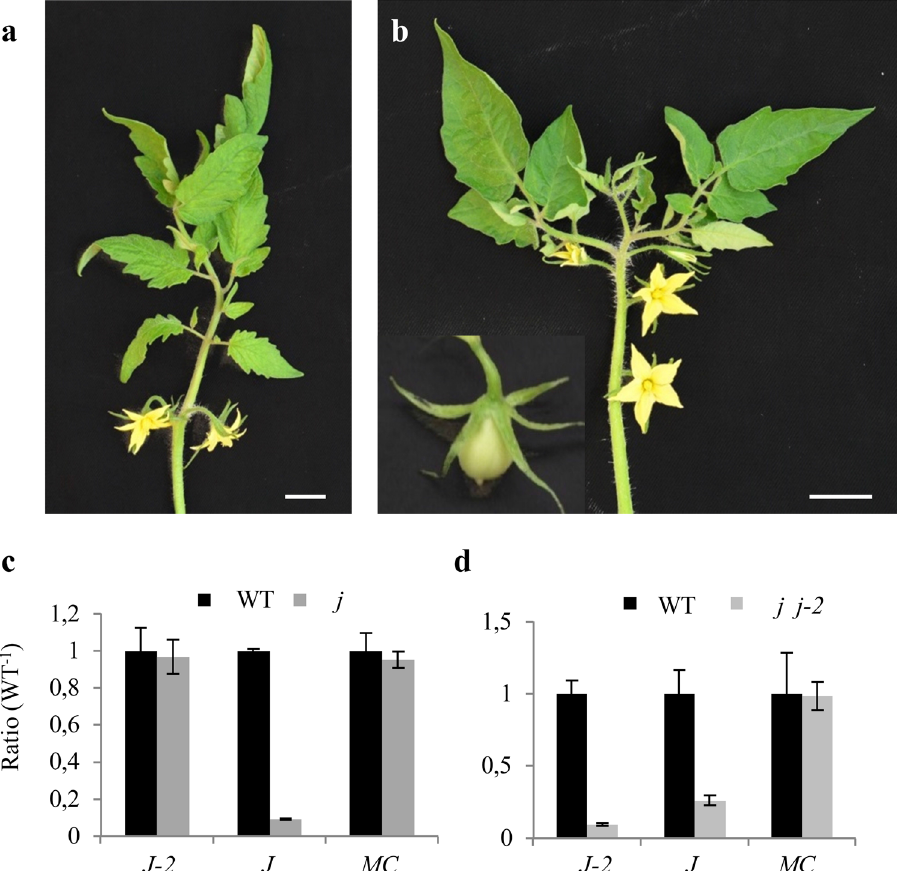
Figure 7. Phenotype of single j mutant and double j j-2 mutant. ( a ) Leafy inflorescence of j mutant. ( b ) Leafy, branched inflorescence and elongated fruits in the j j-2 line obtained by Philouze 22 . Scale = 1 cm. ( c ) Expression levels of J-2 , J and MC in j mutant, relative to WT (var. Gardener). ( d ) Expression levels of J-2 , J and MC in j j-2 mutant, relative to WT (var. Pearson). J-2 ( SlMBP21 ), J ( JOINTLESS ), MC ( MACROCALYX ). Bars =